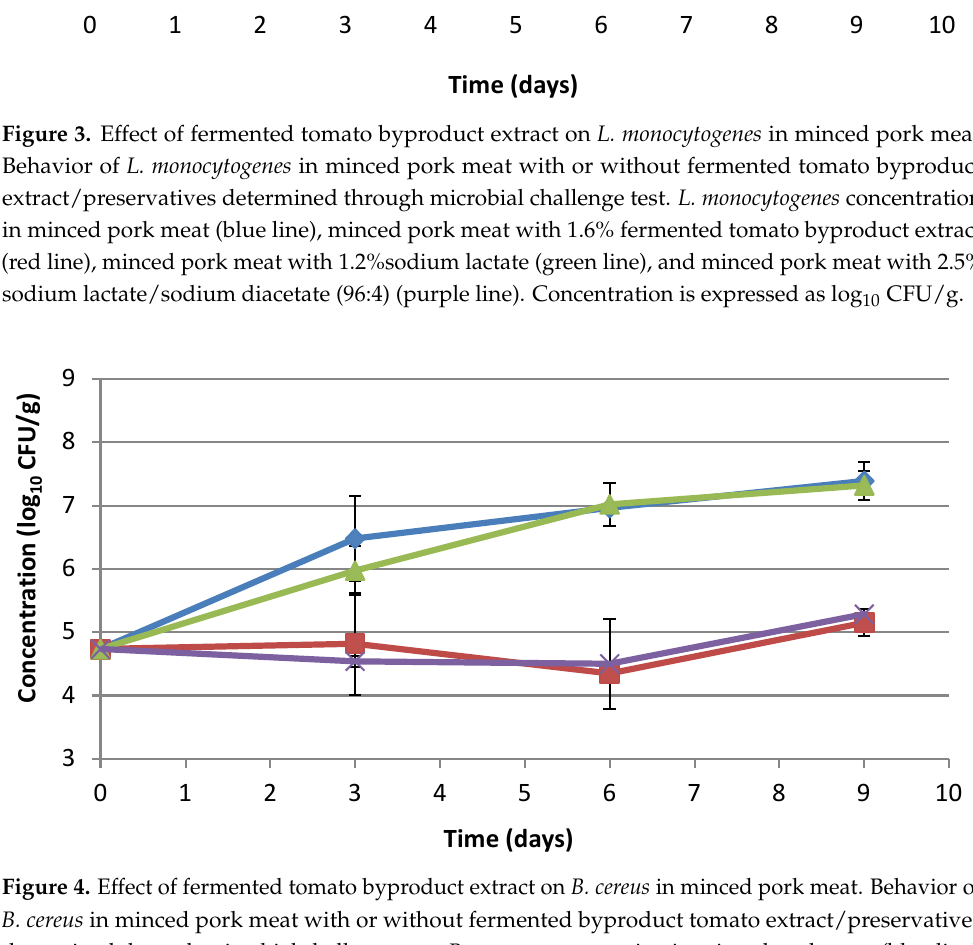
Figure 4. Effect of fermented tomato byproduct extract on B. cereus in minced pork meat. Behavior of B. cereus in minced pork meat with or without fermented byproduct tomato extract/preservatives determined through microbial challenge test. B. cereus concentration in minced pork meat (blue line), minced pork meat with 1.6% fermented byproduct tomato extract (red line), minced pork meat with 1.2% sodium lactate (green line), and minced pork meat with 2.5% sodium lac- tate/sodium diacetate (96:4) (purple line). Concentration is expressed as log 10 CFU/g.